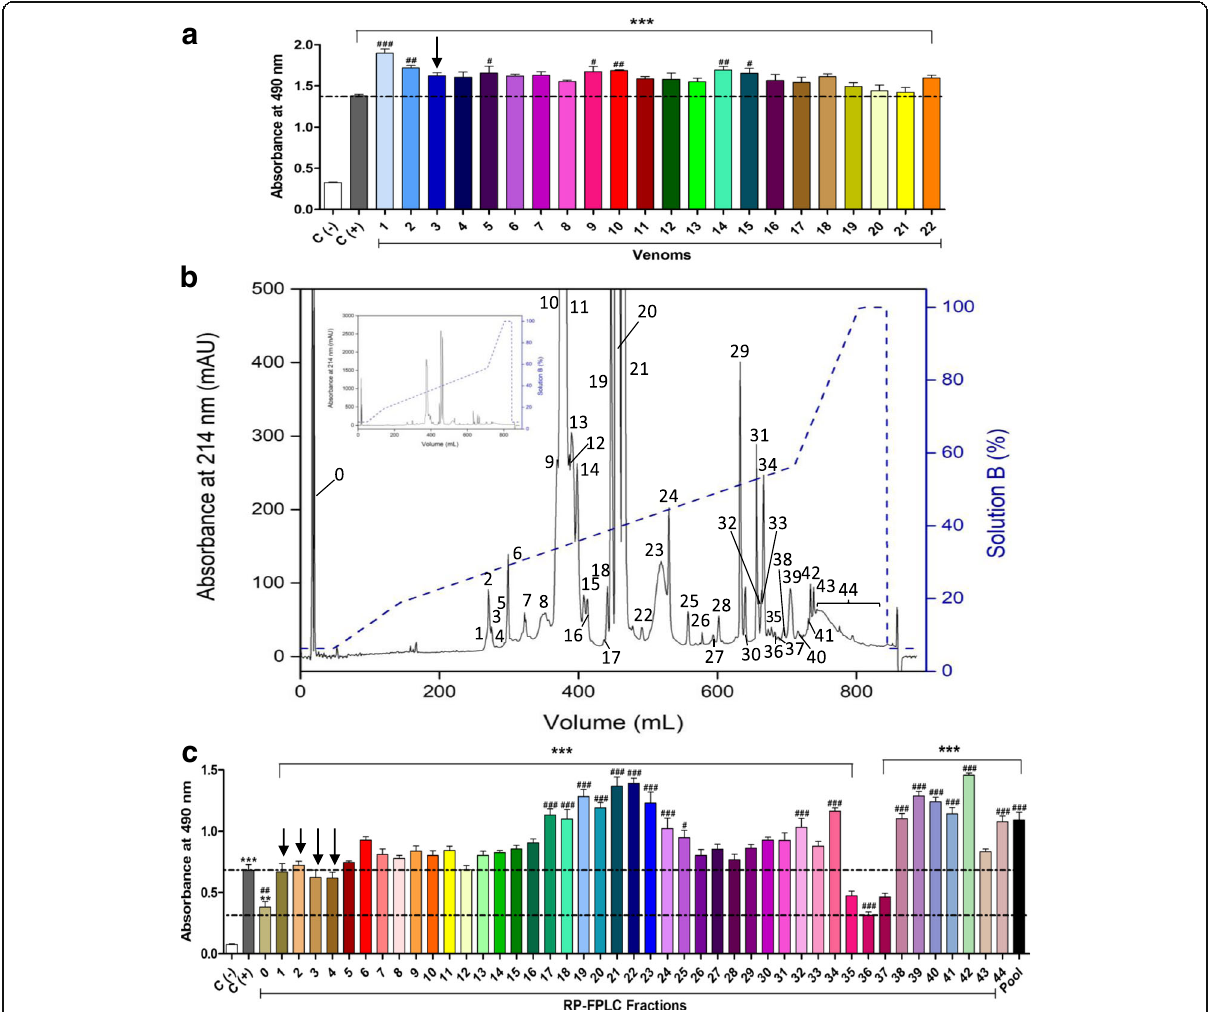
Fig. 1 Antivenom recognition of C. d. collilineatus venoms and fractions performed by indirect enzyme-linked immunosorbent assay (ELISA) and chromatographic profiles of pooled venom. The 96-well plates were sensitized with 2 μ g of (a) venoms (1 – 22) and (c) RP-FPLC fractions (0 – 44) diluted to 100 μ L with carbonate-bicarbonate buffer (pH 9.6). The commercial anticrotalic serum (1,100) from Instituto Butantan was used to evaluate its capacity to recognize the venoms and their fractions using antihorse polyclonal antibodies peroxidase-labeled (1,3000) as secondary antibody. Positive control (C+): wells sensitized with anticrotalic antivenom (represented by horizontal dashed lines). Negative control (C-): non- sensitized wells. Absorbance reading was performed at 490 nm. Data are presented as mean ± SD, which were analyzed by ANOVA and Tukey ’ s multiple comparison test (quadruplicate assay). * p <0.05, ** p <0.01 and *** p <0.001 compared to C-; # p <0.05, ## p <0.01 and ### p <0.001 compared to C+. The arrow indicates crotamine-positive venom and fractions. (b) RP-FPLC of C. d. collilineatus pooled venom (22 mg) on a C18 column was carried out in a segmented concentration gradient from 6.3 to 100% of solution B (80% ACN in 0.1% TFA, represented by the blue dashed line) at a flow rate of 5 mL/min. Inset panel – whole chromatographic profile without